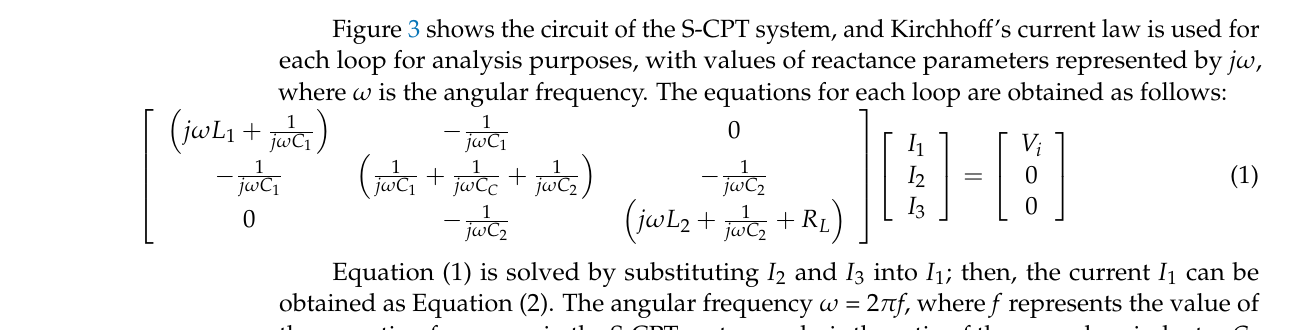
Figure 3. Simplified equivalent circuit for S-CPT.